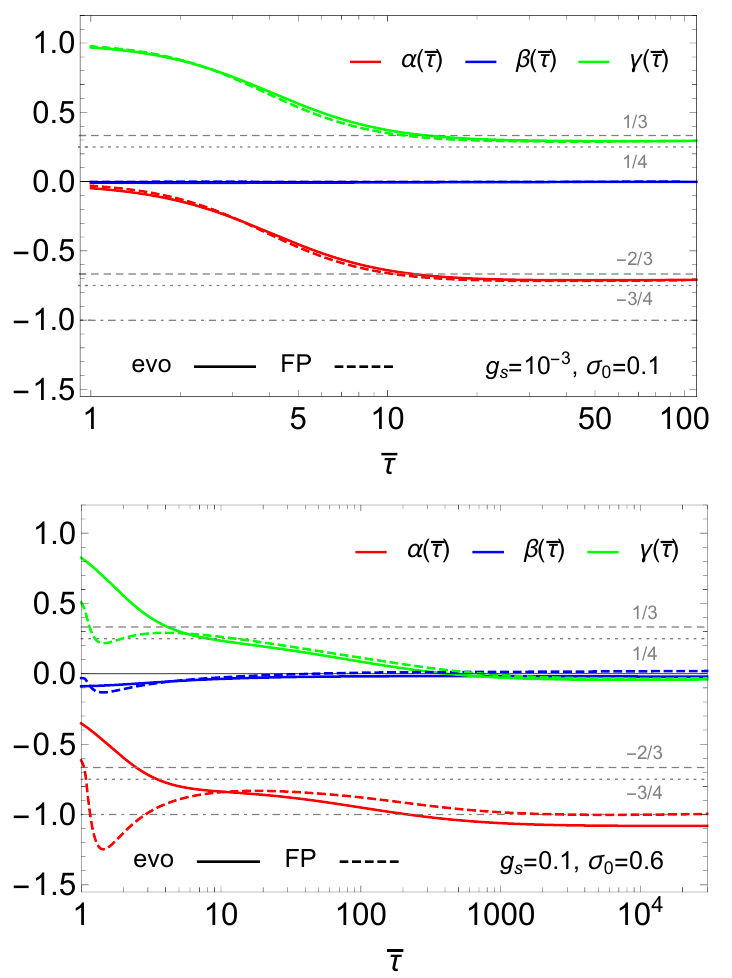
Figure 7 . We compare the evolution of the scaling exponents from eq. (6.6) (solid curves) with results from the FP equation (dashed). In the top panel we take the same initial distribution function for both the evolution equations and the FP equation at τ I . In the bottom panel we specify initial conditions for eq. (6.6) at ¯ τ S = 3 . 1 (see text for details), corresponding to the approximate time for scaling (see the middle panel of figure 2). For clarity of presentation, in both panels the dashed curves are the average of exponents computed from different sets of moments of the distribution